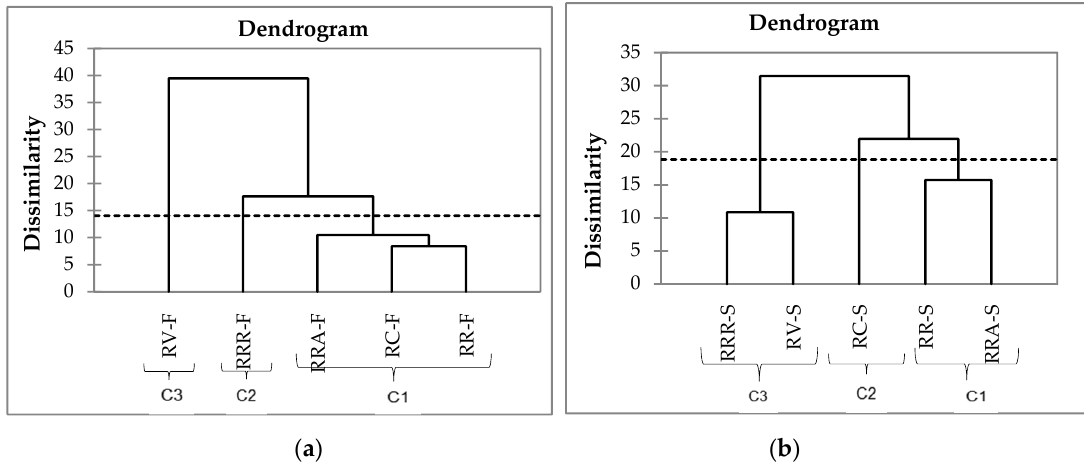
Figure 4. Hierarchical cluster analysis (HCA) of different organic rosehip flesh ( a ) and seed ( b ) samples based on 19 variables. Investigated samples are clustered using Euclidean distance and Ward’s method. Abbreviations: RV-F: Rosa villosa -flesh; RRR-F: Rosa rugosa ‘Rubra’-flesh; RRA-F: Rosa rugosa ‘Alba’-flesh; RC-F: Rosa canina -flesh; RR-F: Rosa rugosa -flesh; RV-S: Rosa villosa -seeds; RRR-S: Rosa rugosa ‘Rubra’-seeds; RRA-S: Rosa rugosa ‘Alba’-seeds; RC-S: Rosa canina -seeds; RR-S: Rosa rugosa - seeds.